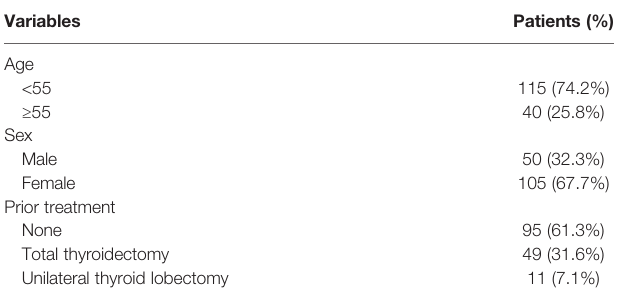
TABLE 1 | Information of the enrolled 155 patients.